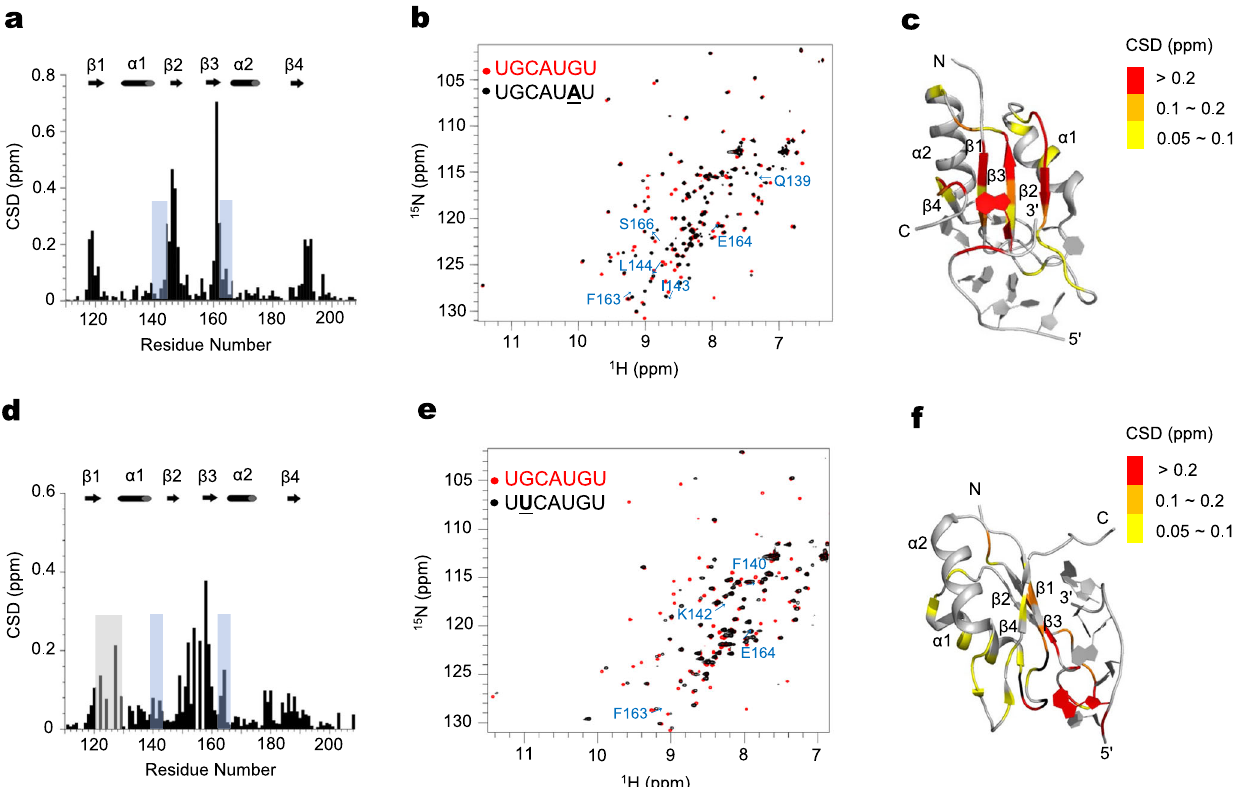
Fig. 5 | NMR analysis of the interaction of RbFox RRM with its consensus RNA and two RNA variants. a Chemical shift difference (CSD) between RbFox RRM bound to its cognate RNA 5 ’ -UGCAUGU and RNA1 5 ’ -UGCAUAU. Regions with sig- ni fi cant CSD while distant from the RNA-binding site are highlighted in blue. b Superposition of 1 H- 15 N HSQC spectra of RbFox RRM complexed with the two RNAs (red: 5 ’ -UGCAUGU; black: 5 ’ -UGCAUAU). Residues with signi fi cant CSDs dis- tant from the RNA-binding site are labeled in blue. c Mapping of the CSD in panel a onto the structure of RbFox bound to its cognate RNA (pdb #2ERR [https://doi. org/10.2210/pdb2err/pdb]) (red: CSD>0.2 ppm; orange: 0.1 ppm<CSD<0.2 ppm; yellow:0.05ppm<CSD<0.1ppm). d CSDbetweenRbFoxRRMboundtoitscognate